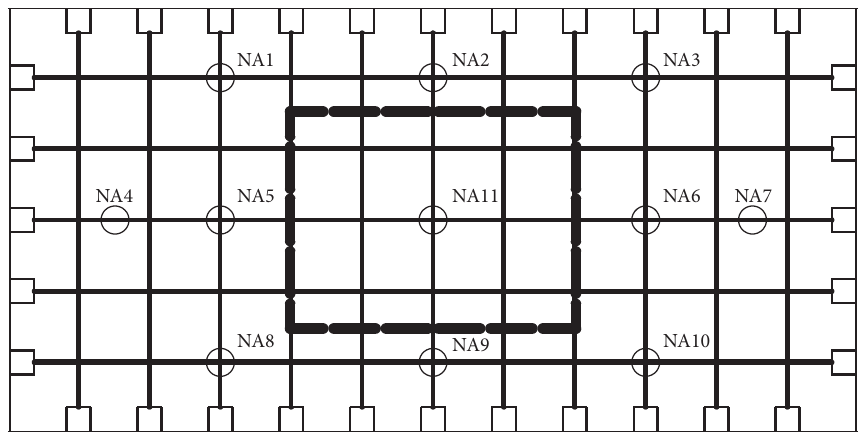
Figure 16: Layout of acceleration measuring points.